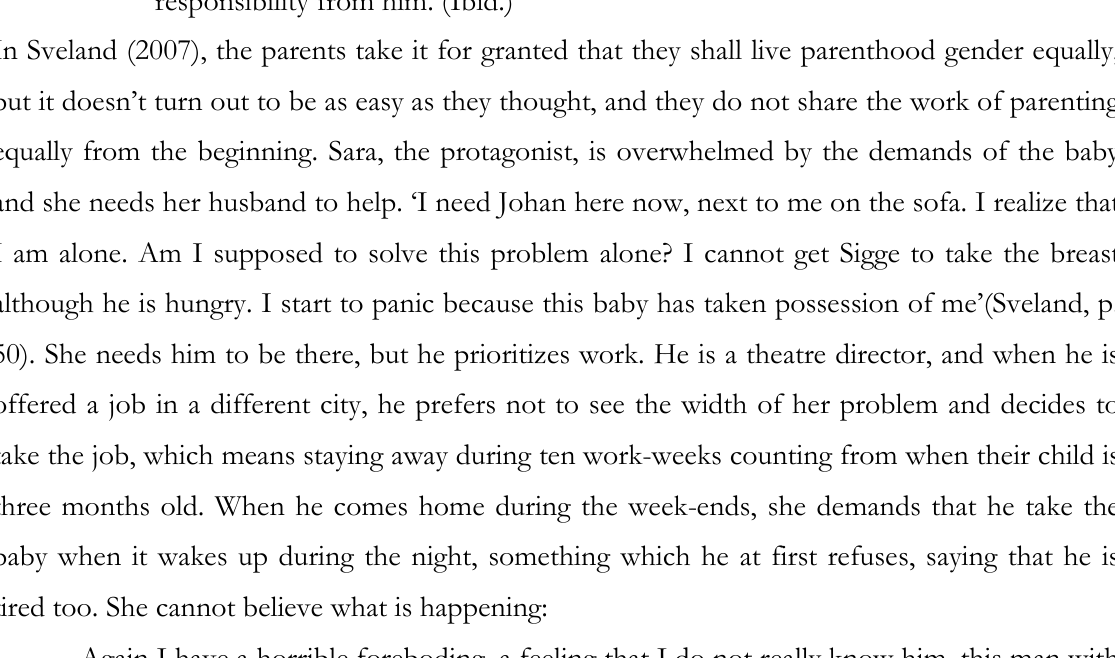
Katarina Carlshamre, Helper and Obstacle: the image of the father in four Swedish mother-narrated novels of the early 21 st Century: Myrén, Nordin, Sandberg and Sveland Studies in the Maternal , 5(2), 2013,